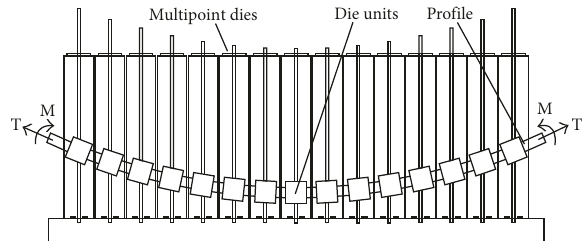
Figure 1: Schematic diagram of the multipoint stretch bending